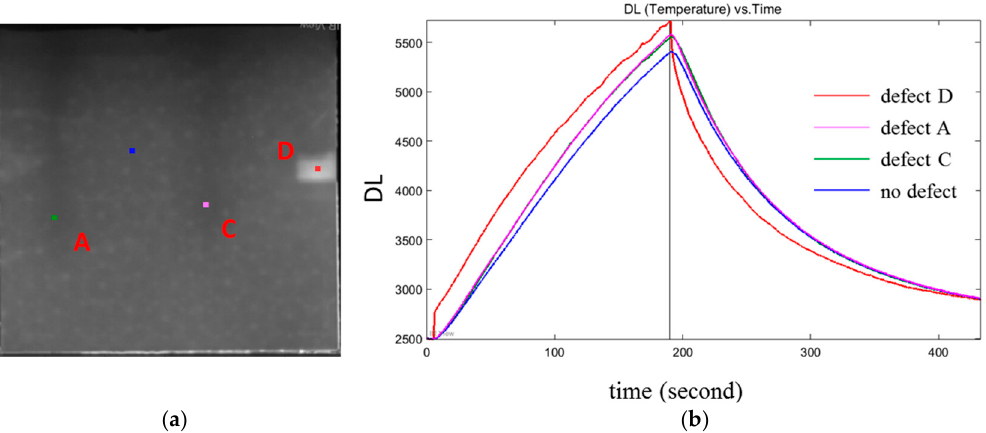
Figure 3. PT results: ( a ) raw thermal image at 180 s in transmission mode and ( b ) temperature change over time at non-defective area and defects A, C, and D.